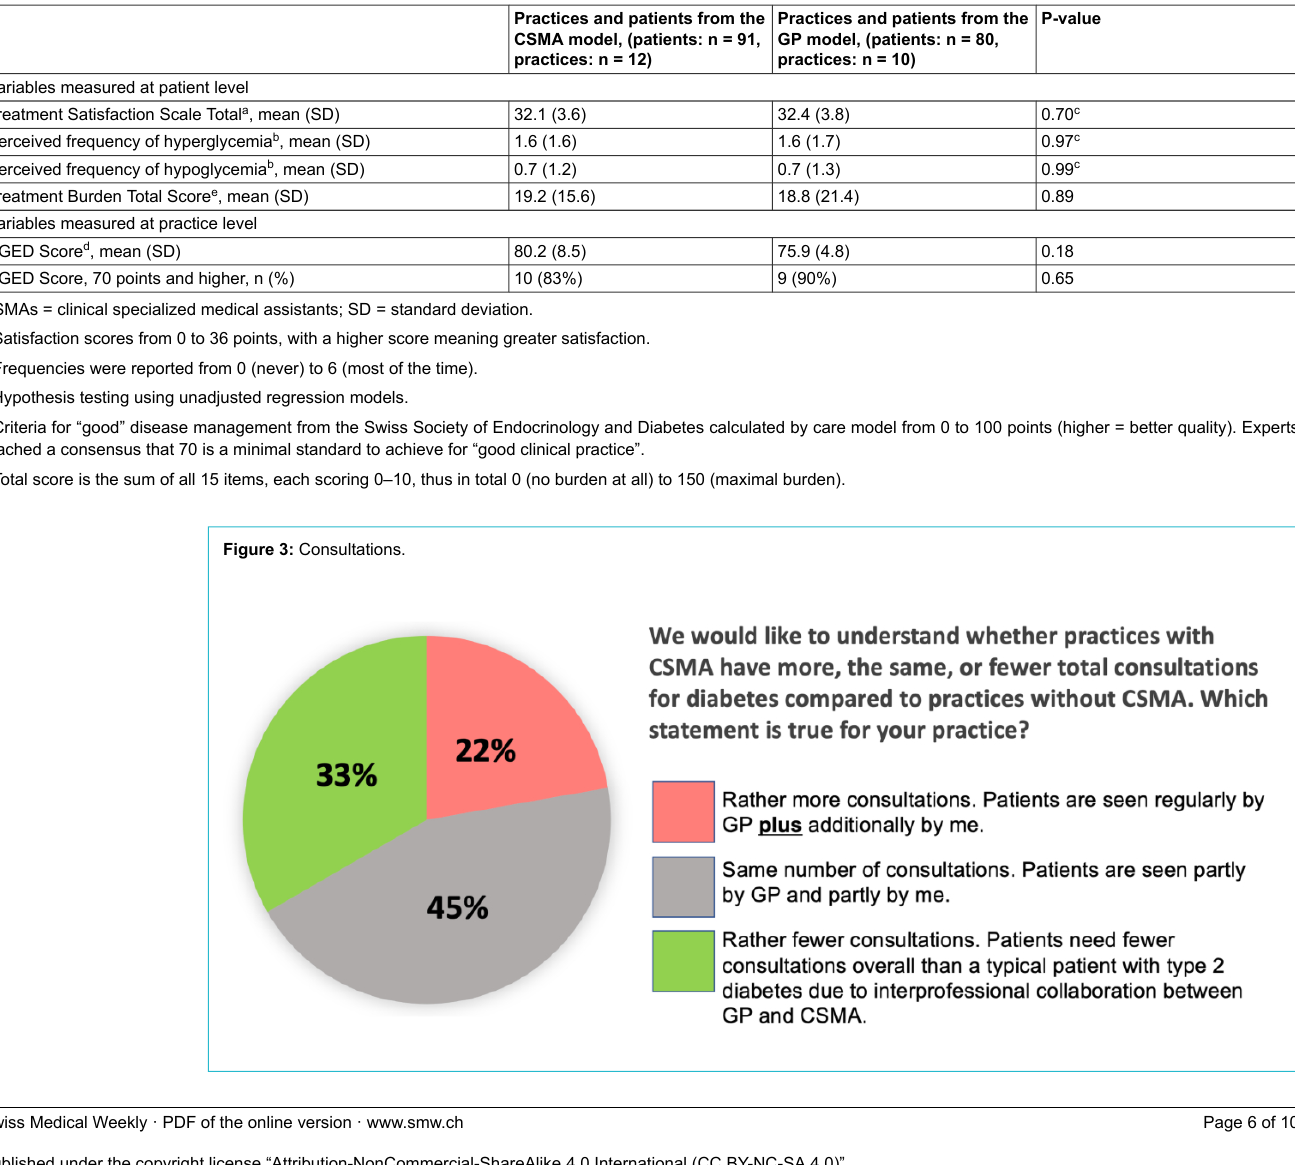
Table 3: Outcomes in practices with and without CSMAs on Diabetes Treatment Satisfaction Questionnaire (DTSQ), SGED score, and Treatment Burden Questionnaire (TBQ).